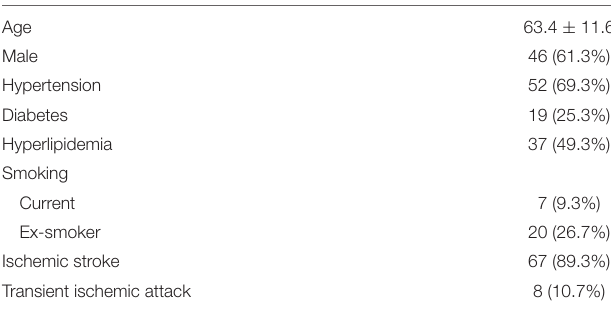
TABLE 1 | Clinical characteristics of the study population ( n = 75).